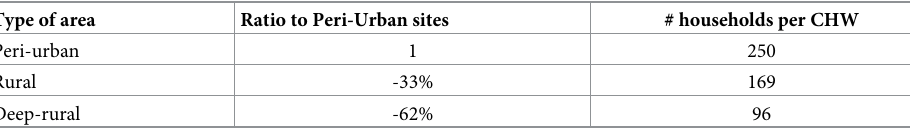
Table 9. Number households per CHW per type of